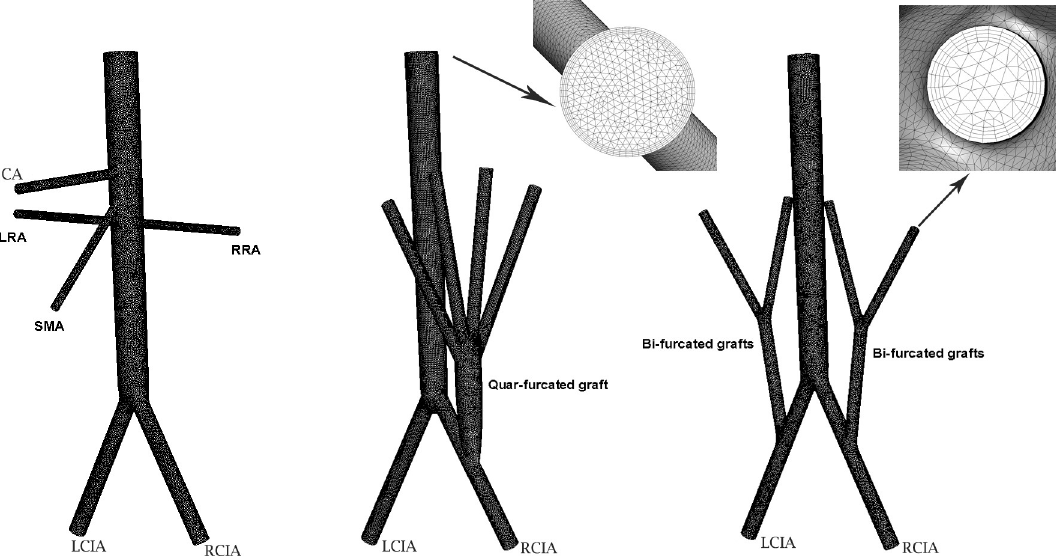
Fig 3. Mesh generations of AA with RVR; A) Structure of normal AA; B) AA with quar-furcated bypass graft; C) AA with bi-furcated bypass graft; D) Zoom-in View of boundary